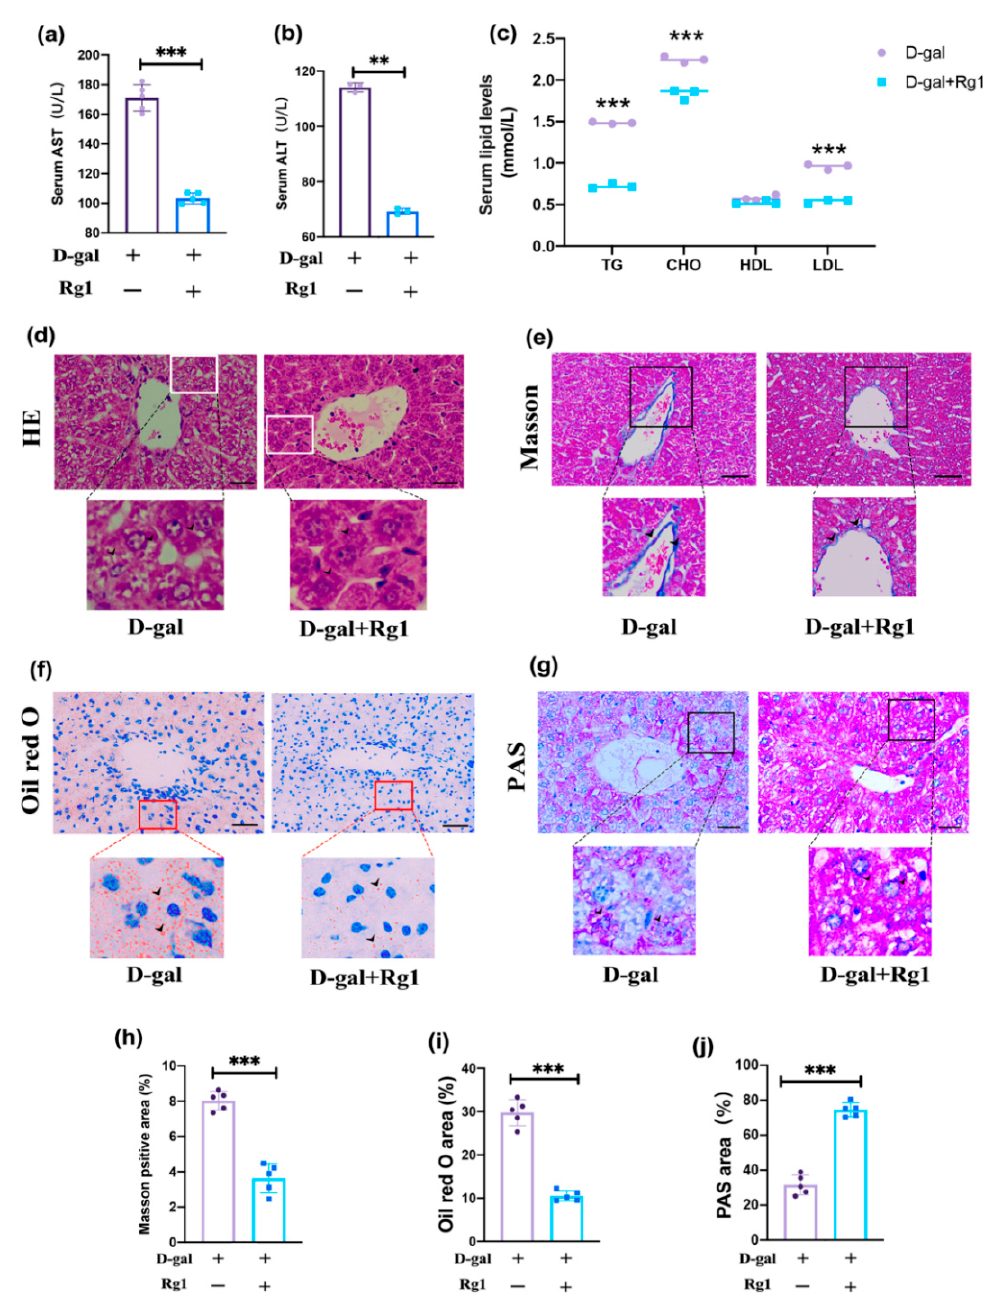
Figure 2. Rg1 alleviated the oxidative stress damage-related hepatocyte dysfunction: ( a ) The AST and ( b ) ALT levels in serum were detected ( n = 5/group). ( c ) The serum lipid levels were measured ( n = 5/group) ( d ) Hematoxylin and eosin staining (magnification, × 400, scale bar, 20 µ m) ( e , h ) Masson staining and quantitative results of the percentage of cells in the liver of different experimental groups (magnification, × 400, scale bar, 20 µ m). ( f , i ) Oil O Red staining was measured and quantitative analysis of lipid drops was detected (magnification, × 400, scale bar, 20 µ m). ( g , j ) Periodic acid–Schiff staining and a quantitative analysis of hepatic glycogen were conducted (magnification, × 400, scale bar, 20 µ m). Images were analyzed using Image J software ( n = 5/group). Data represented by means ± SD in ( a – c , h – j ). (** p < 0.01 and *** p < 0.001, Student’s t